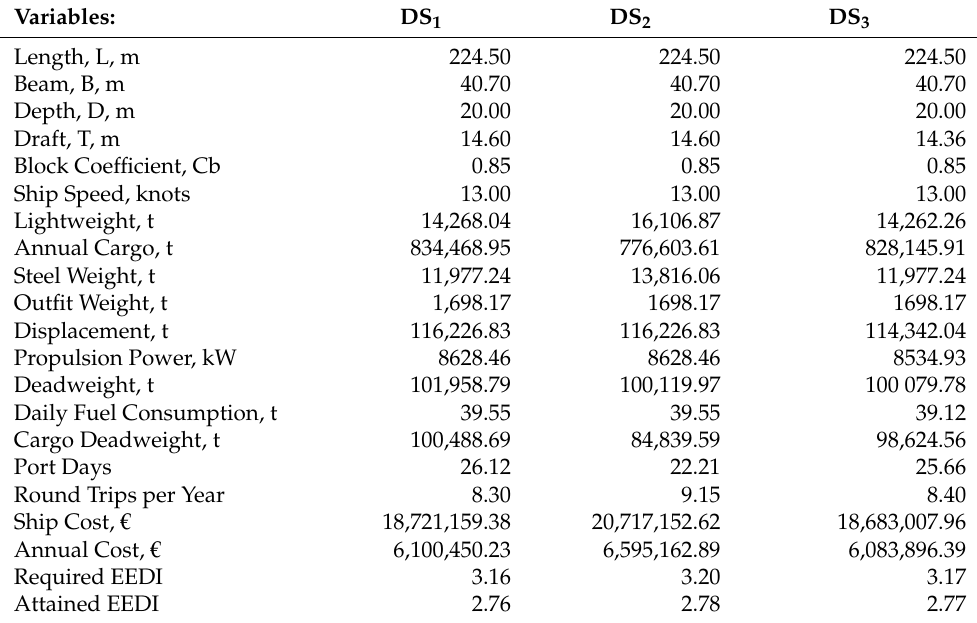
Table 2. Ship design bulk carrier